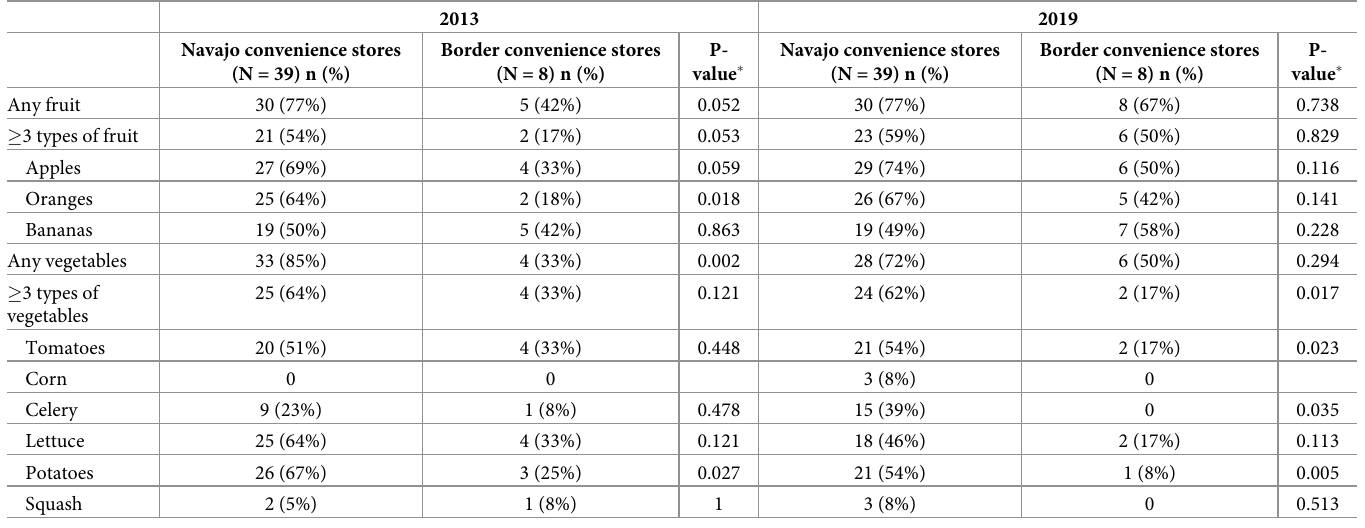
Table 2. Percentage of convenience stores offering healthier items in 2013 and 2019, n = 51.